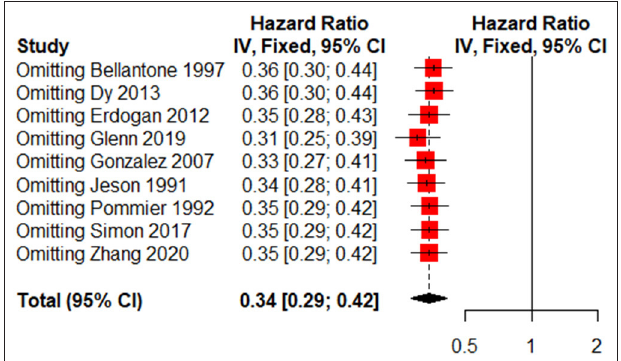
FIGURE 5 | Sensitivity analysis of reoperation for recurrent